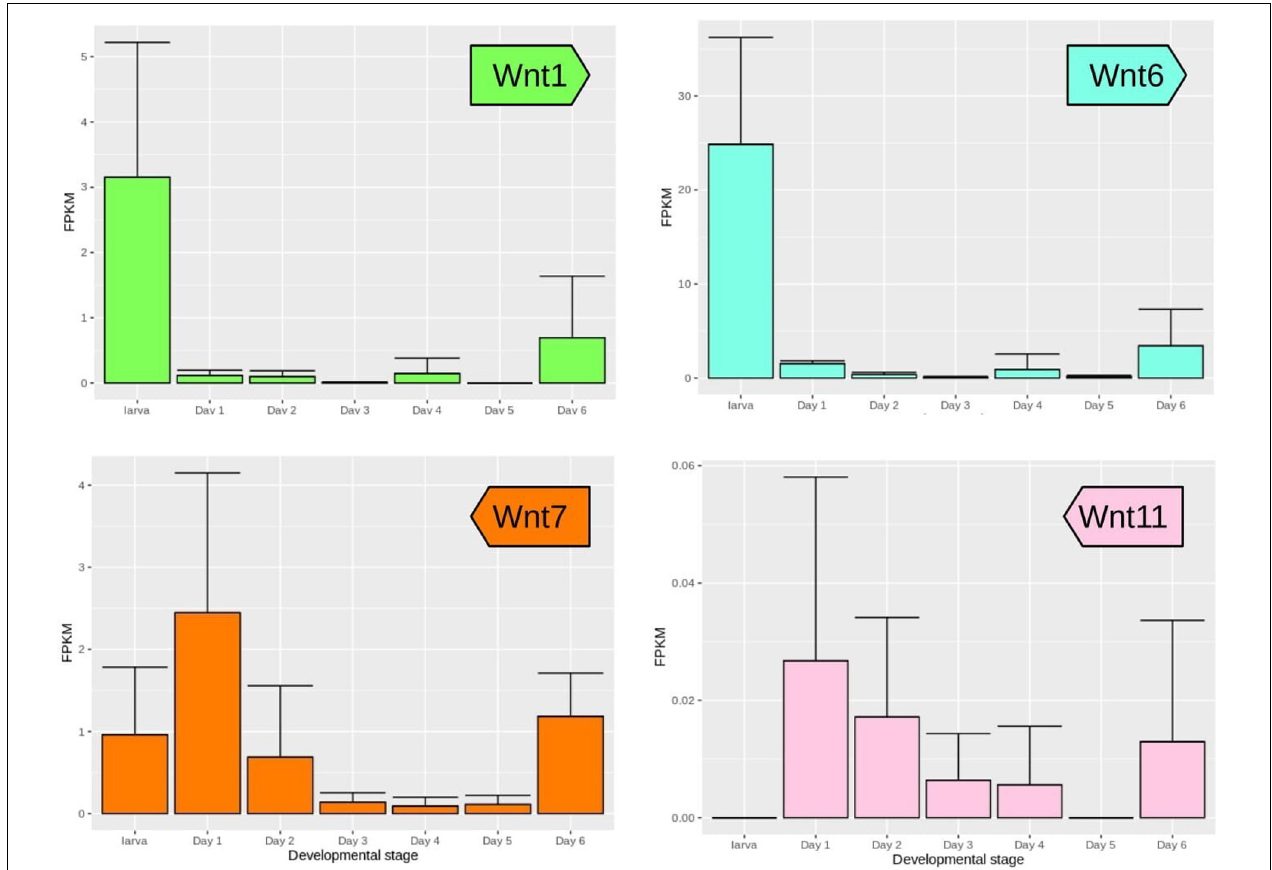
FIGURE 2 | Wnt gene expression during wing development of Z. cesonia . Mean and standard error of expression levels among replicates from larval fifth instar through pupal wing development. Note the scale of FPKM (fragments per kilobase of transcript per million mapped reads) on y -axes differ among genes, due to large differences in expression